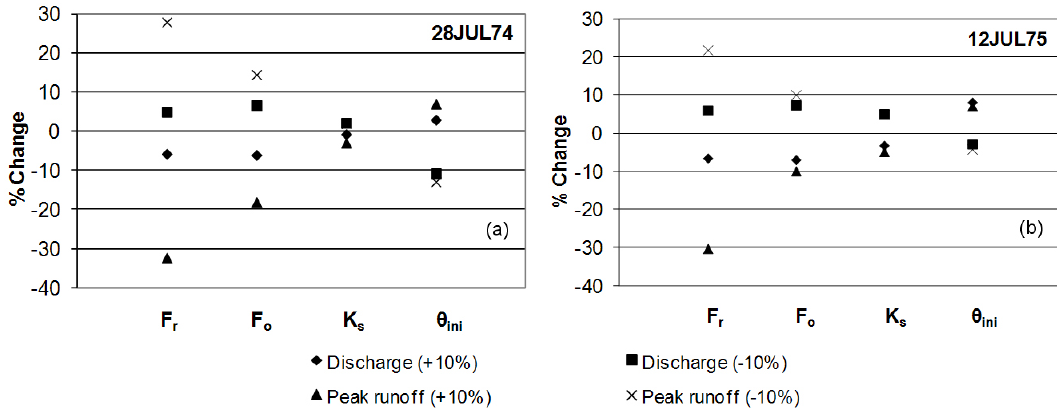
and F are Manning coefficients r o